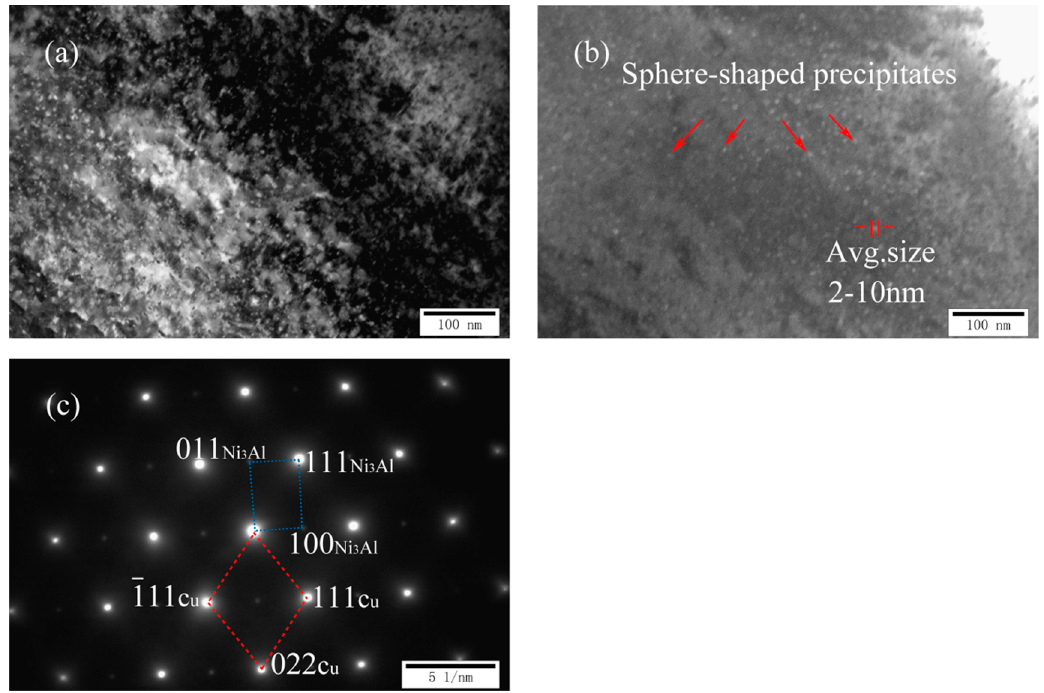
Figure 3. Microstructures of cast Cu-7Ni-lAl-1Fe-1Mn alloy: ( a ) bright-field image; ( b ) dark-field image; and ( c ) the corresponding SADP of ( a ).